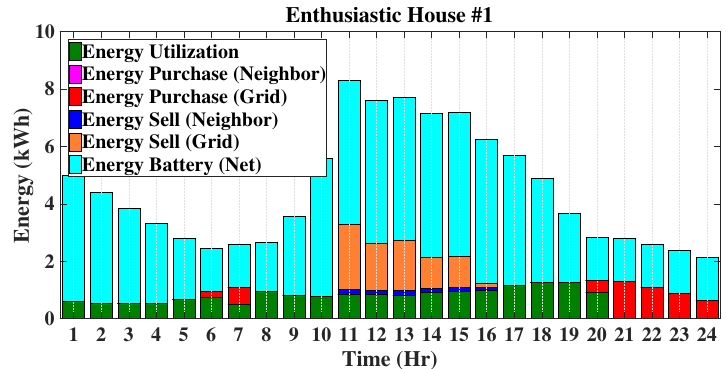
Figure 17. Energy profiles of Enthusiastic House #1 on a typical summer day.